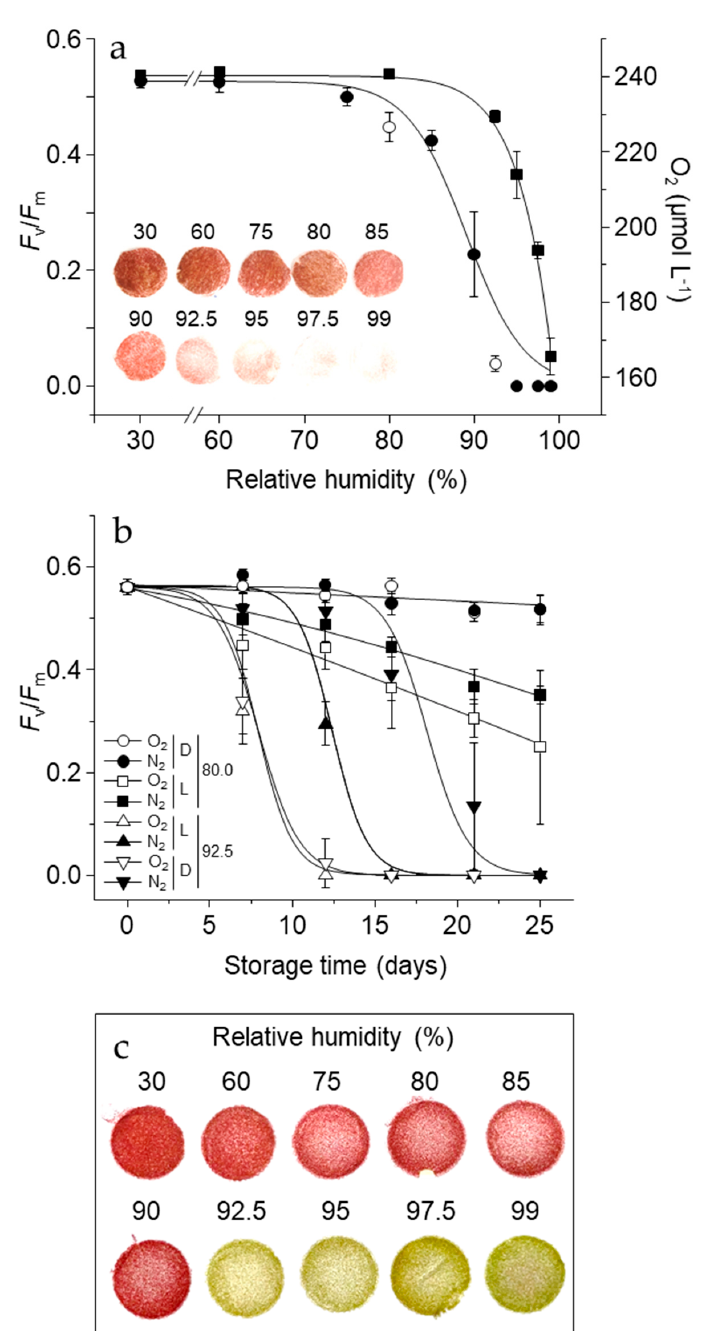
Figure 4. Interaction of oxygen, light and RH on cell longevity and pigment bleaching. F v /F m values after 48 h rehydration, as a viability indicator, of cells stored for ( a ) 20 days in light at various RH, and ( b ) up to 25 days at 80.0% or 92.5% RH in dark (D) or LL and in high oxygen tension (O 2 ; open symbols) or low oxygen tension (N 2 ; closed symbols), n = 4 ± SD. Open circles in ( a ) denote the RHs used in ( b ). Squares in ( a ) show oxygen concentrations (right Y axis) of the atmosphere surrounding dark hermetically stored cells after 20 days. The inset in ( a ) shows typical filters after four days rehydration, with pigment bleaching indicative of viability loss. ( c ) Images of dry cells on filters after eight weeks storage at various RH in the dark and under a high oxygen tension.